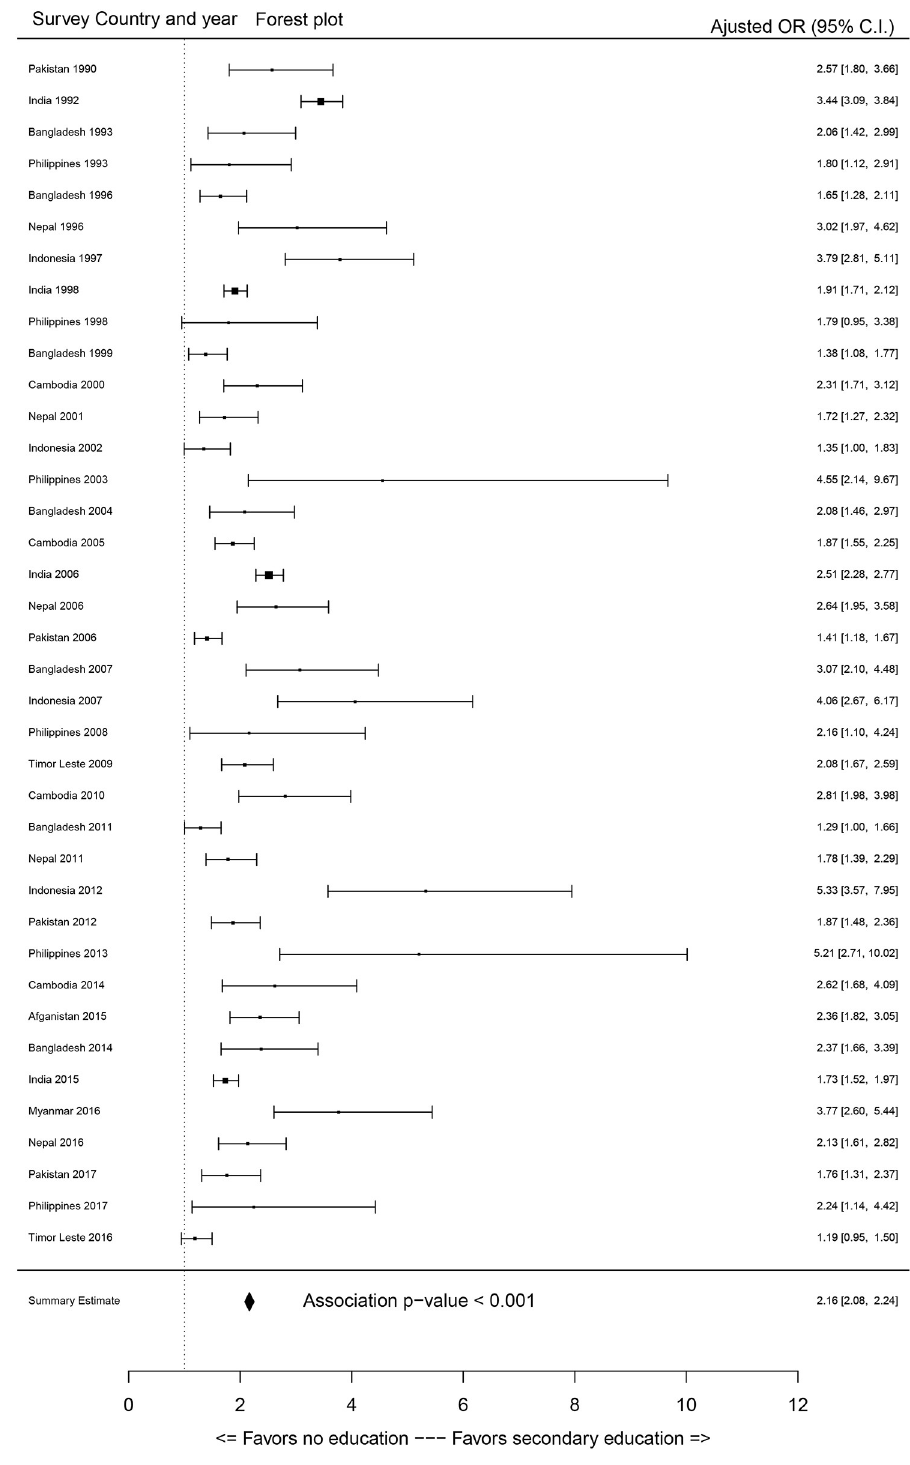
Fig 3. Forest plot odds of women having secondary education on access to skilled birth attendants compared to women with no education (OR = odds ratio, C.I. = confidence interval).